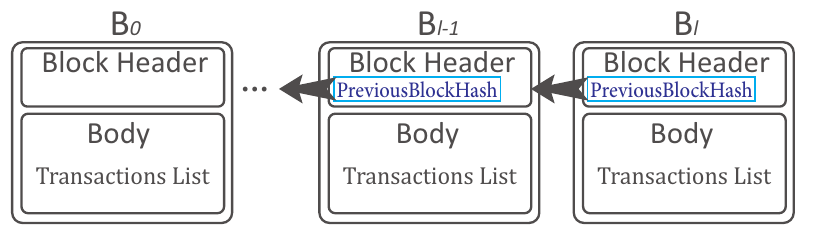
Figure 1. Blockchain